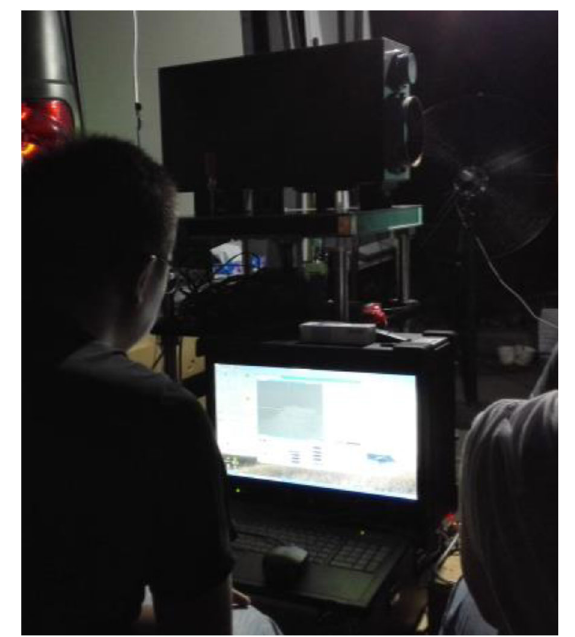
Fig. 16 Seeker optical imaging system